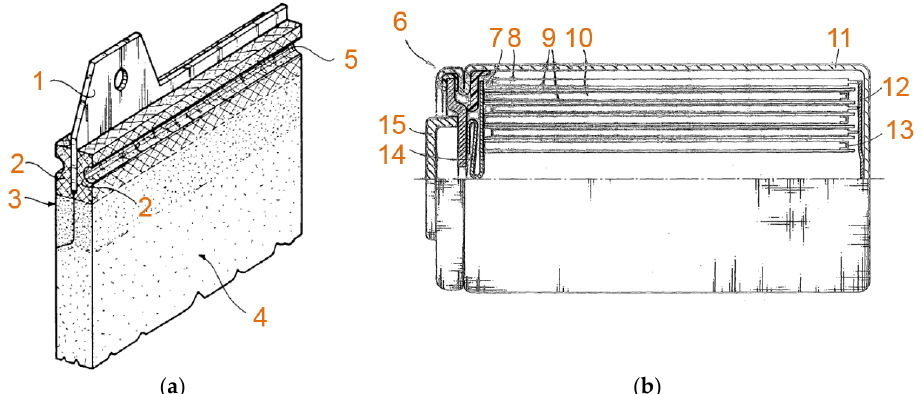
Figure 7. Schematics of ( a ) A metal-foam connection and ( b ) A cylindrical cell design from Alcatel.